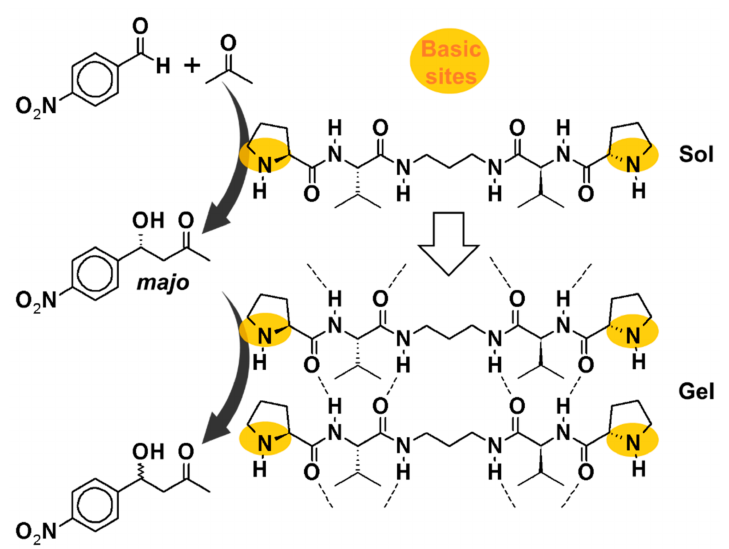
Figure 46. An aldol reaction between acetone and 4-nitrobenzaldehyde catalyzed by an L -proline derivate in acetonitrile solution and racemization in a supramolecular